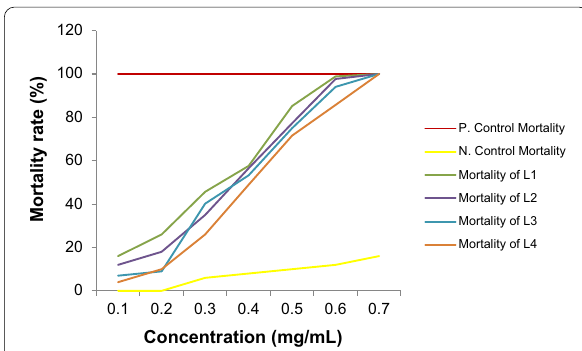
Fig. 2 Larval mortality based on concentrations of extract of Albizia lebbeck after 24 h of exposure